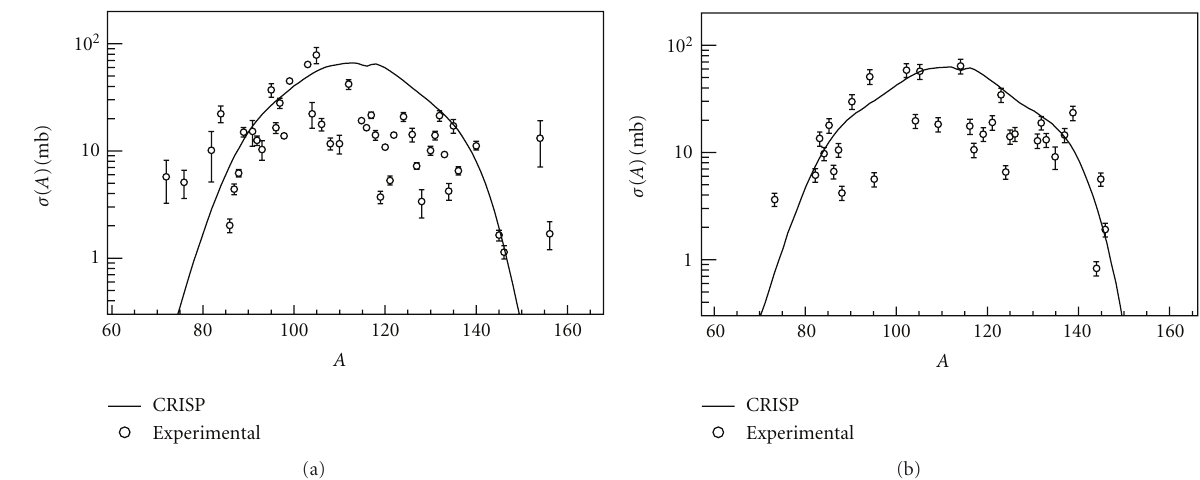
Figure 1: Cross section of fragments produced in the fission of 241 Am (a) and 237 Np as a function of fragment mass (b) induced by 660 MeV protons. Values from the systematic study of [9] for the parameters corresponding to the three fission modes considered in this work (—) were used. Open symbols ( ◦ ) are the experimental data [10].